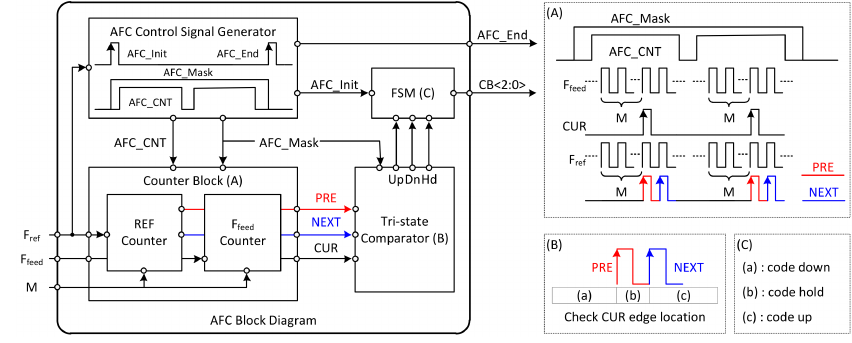
Figure 8. Entire block diagram of the AFC.